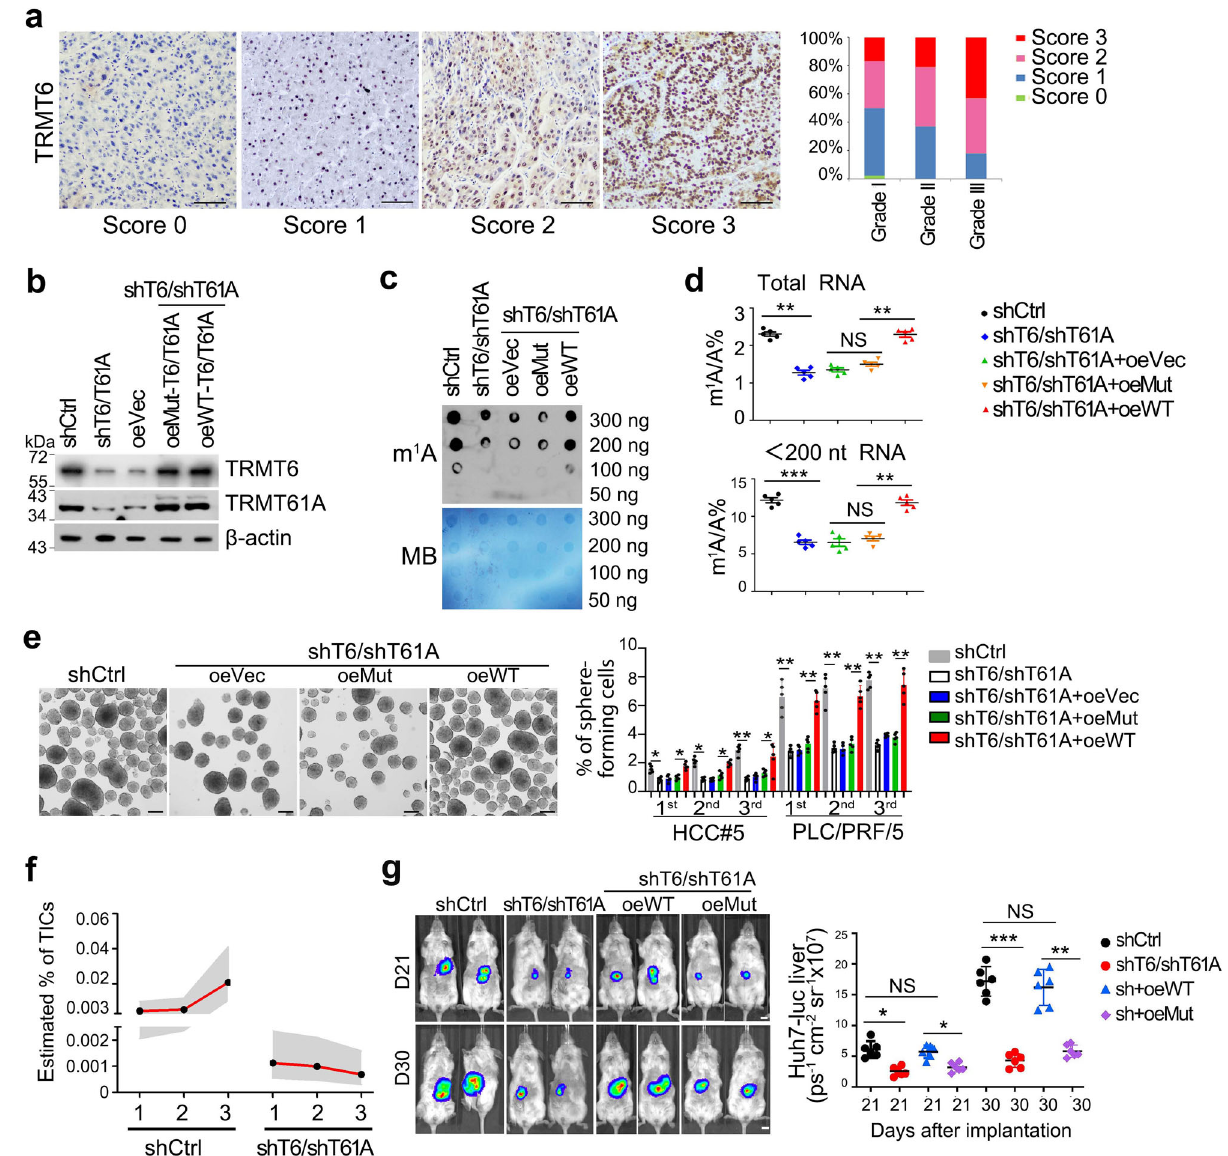
Fig. 2 TRMT6/TRMT61A-mediated m 1 A modi fi cation drives self-renewal of liver CSCs and tumourigenesis. a Representative immunohistochemistry images of TRMT6 protein levels (brown) in the cohort of 191 HCC samples. n = 3 independent experiments. Score 0 (0 – 5% positive cells/tissue section) represents TRMT6 staining that is considered negative; score 1 (5 – 15% positive cells/section) represents TRMT6 staining that is considered week positive, whereas scores 2 (15 – 35% positive cells/section) and 3 (>35% positive cells/section) represent TRMT6 staining that is considered positive. Grade I ( n = 56), Grade II ( n = 87), Grade III ( n = 48). Scale bar, 100 μ m. b Western blotting con fi rmation of TRMT6/TRMT61A ( T6/T61A ) depletion, and co- infection of WT or TRMT6 R377L / TRMT61A D181A (Mut) constructs in TRMT6/TRMT61A depleted cells. These experiments were repeated three times. oe overexpression, Vec vector. n = 3 biologically independent samples. c Global m 1 A levels were detected in shCtrl, TRMT6/TRMT61A depletion, and co- infection of WT or Mut- TRMT6/TRMT61A in TRMT6/TRMT61A depleted liver CSCs using dot blot assay. Data were repeated fi ve times. n = 5 biologically independent samples. d LC-MS/MS quanti fi cation of m 1 A levels in total RNA and tRNA (<200 nt) puri fi ed from indicated liver CSCs, presented as percentage of unmodi fi ed A. Data are means ± SD. n = 5 biologically independent samples. Exact P values from left to right (upper): 0.0033, 0.052, 0.0087; left to right (lower): 0.00012, 0.22, and 0.0084. e TRMT6/TRMT61A depletion suppressed serial oncosphere-forming capacity in HCC primary cells and HCC cell lines. Right panel represents statistical results as means ± SD. n = 5 biologically independent cells. Scale bar, 100 μ m. Exact P values from left to right: 0.036, 0.029, 0.031, 0.042, 0.0031, 0.022, 0.0022, 0.0054, 0.0063, 0.0072, 0.0050, 0.0064. f Estimated frequency of tumor initiating cells (TICs) in TRMT6/TRMT61A depleted and control liver CSCs during serial transplantations in NSG mice. Data are presented as mean values (black spot) and upper/lower values (gray area). n = 10 mice per group. g Four kinds of knockdown and rescued Huh7 CSCs with green fl uorescent protein (GFP) – luciferase tags (Huh7-Luc) were orthotopically implanted into NSG mice. HCC tumor growth rates of with orthotopic engraftment were monitored in vivo by whole NSG mouse imaging after 21 and 30 days post-transplantation, respectively. Scale bar, 1 cm. Right panel represents statistical results as means ± SD. n = 6 mice per group. Exact P values from left to right: 0.023, 0.064, 0.040, 0.00071, 0.053, 0.0085. * P < 0.05; ** P < 0.01; *** P < 0.001, and NS not signi fi cant ( P > 0.05) by two-tailed Student ’ s t -test.